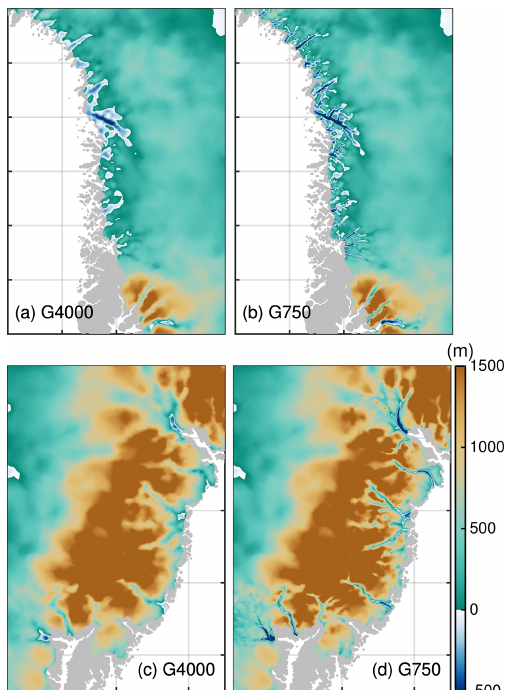
Figure 3. G4000 and G750 bedrock topography for the northwest- ern region ( a, b , respectively), and for the southeast region ( c, d , respectively). Region subsets are shown in Fig.